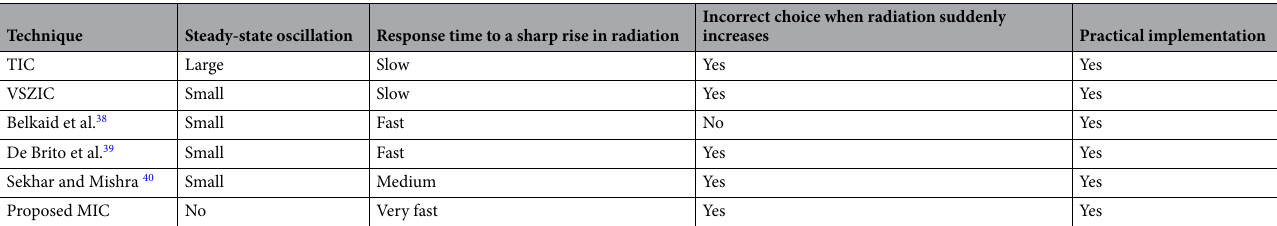
Table 6. The proposed approach comparison to various modified incremental conductance algorithms that have been proposed in published